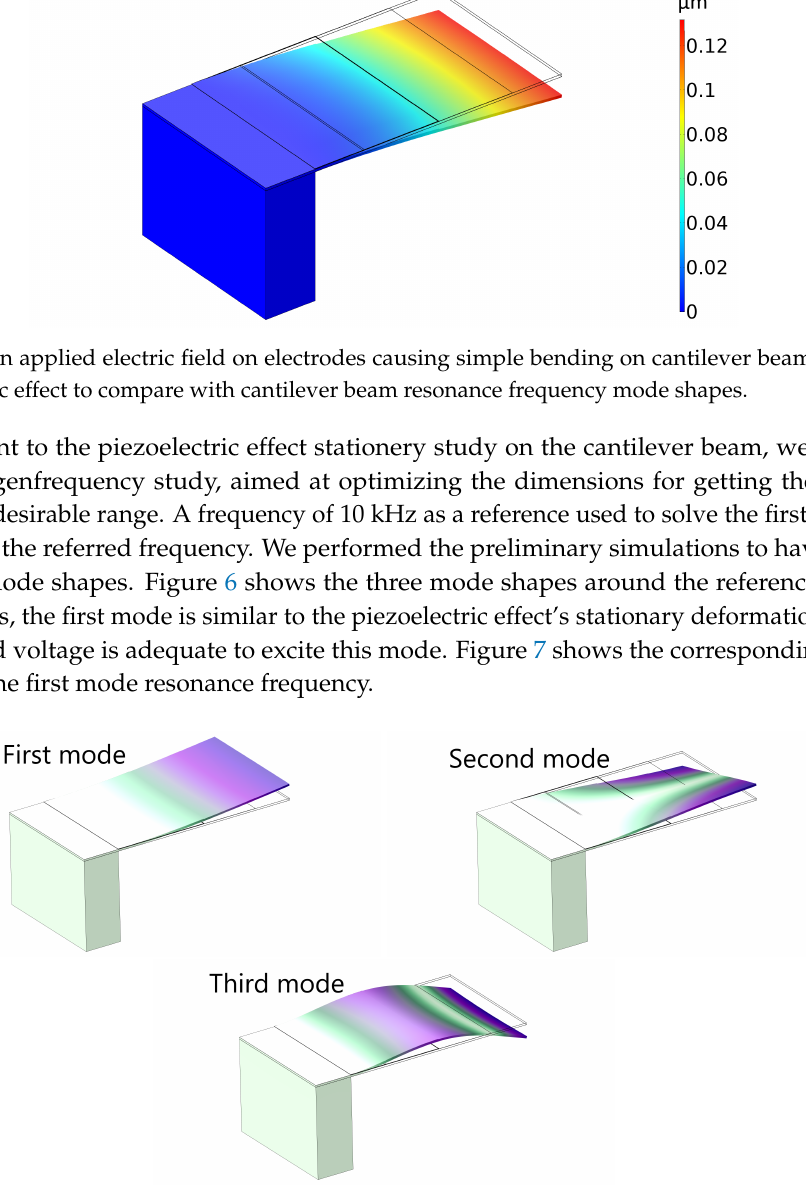
Figure 6. The cantilever beam first three mode shapes for resonance frequency obtained from eigenfrequency study around 10 kHz. The first mode shape is identical to the cantilever simple bending due to the piezoelectric